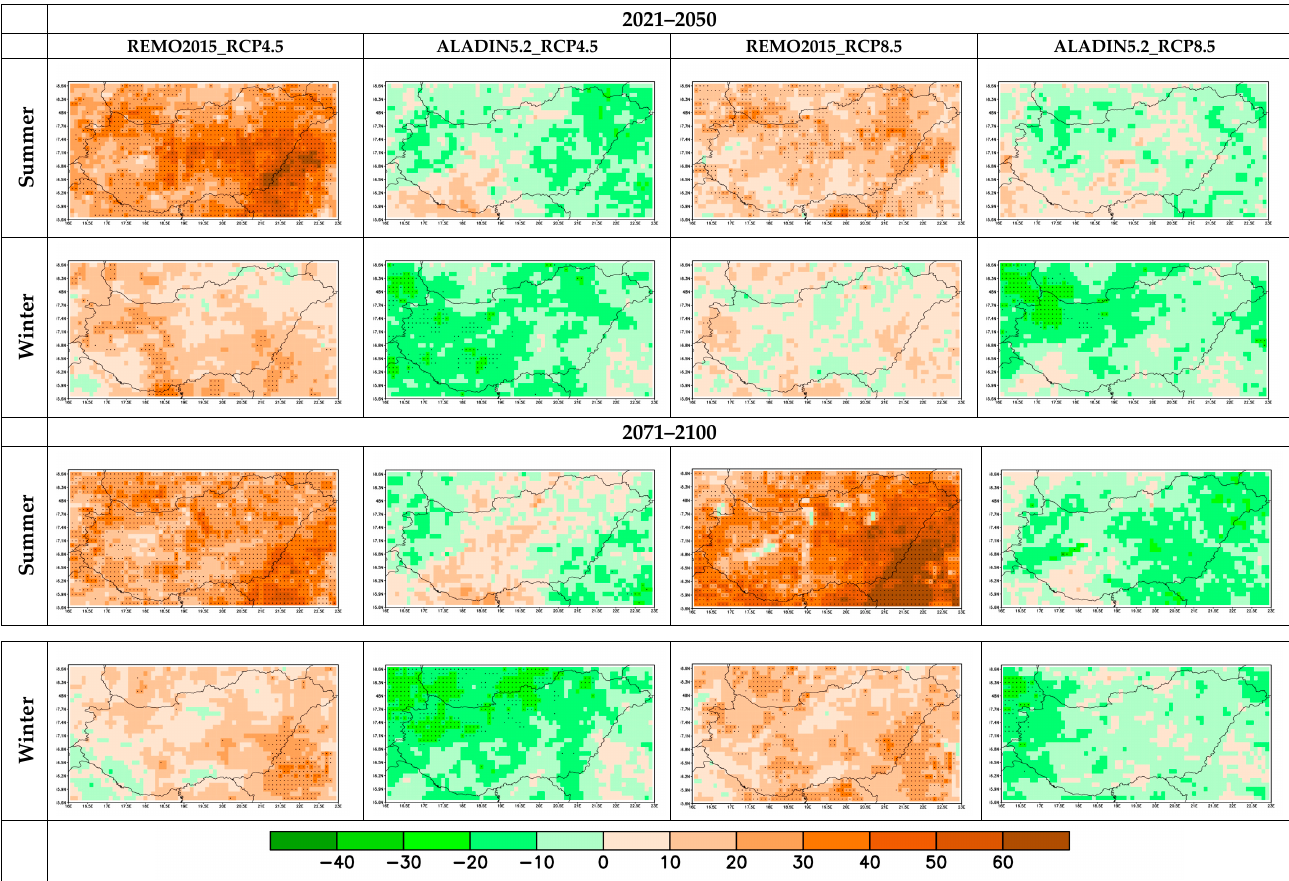
Figure 22. Relative change in the number of consecutive dry days (%) in summer and winter in Hungary for 2021–2050 and 2071–2100 based on the ALADIN5.2 and REMO2015 simulations. Reference period: 1971–2000.